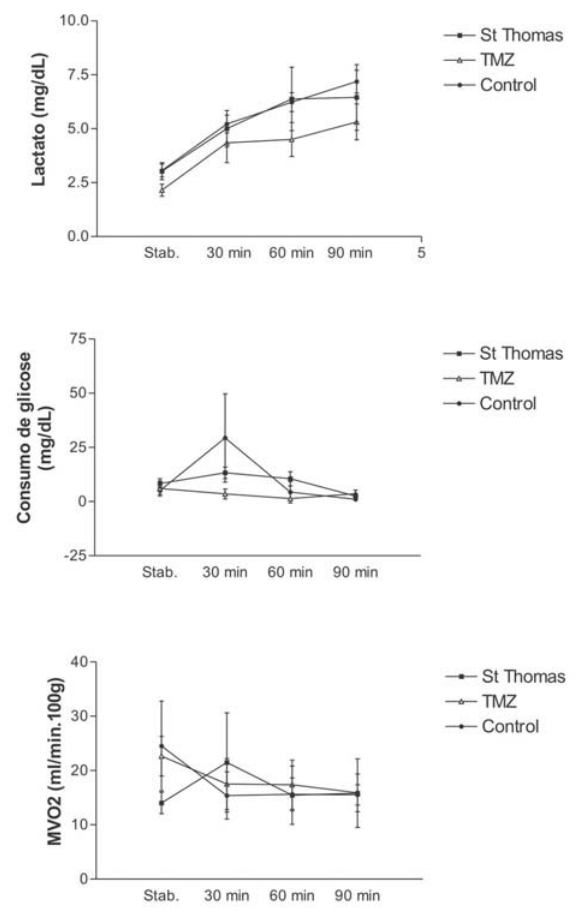
Fig. 5 - Dados metabólicos. Lactato efluente do coração isolado (acima), consumo de glicose (médio) e consumo de oxigênio (abaixo) do coração isolado. Medidas de estabilização e aos 30, 60 e 90 minutos de reperfusão em modo “working heart” após períodos de isquemia regional e global. Dados apresentados como média e dois erros padrão da média (EPM) (n = 6) em cada grupo